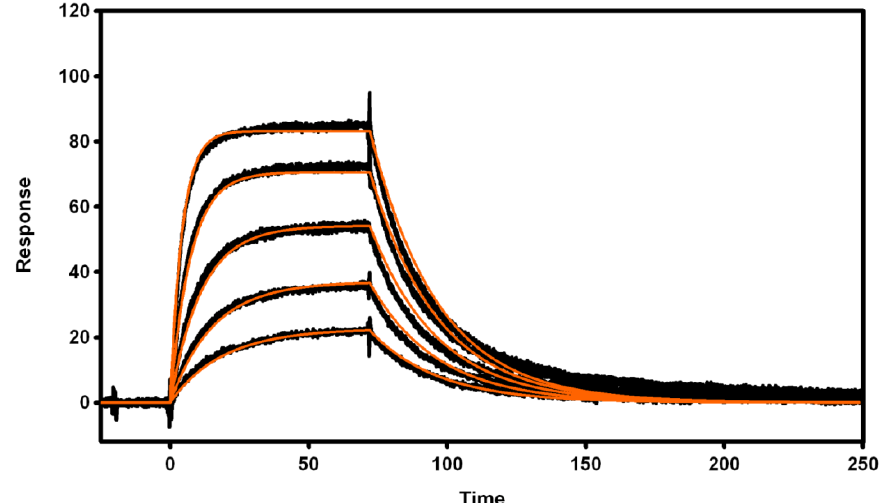
Figure A1. SPR analysis of 4A-1 V 5G8 IgG (1450 RU) was analyzed at a constant flow rate of 50 µL/min with an injection volume of 50 µL. Injected concentrations were 8, 4, 2, 1 and 0.5 µM. No regeneration was required between injection cycles as the bound 4A-1 V 300 s in the running buffer. Binding data (black lines, in triplicate) were fitted globally with a 1:1 kinetic interaction model (red lines) yielding a k 0.04 s −1 and an equilibrium dissociation constant ( K instrument docked with COOH1 chip was utilized for this